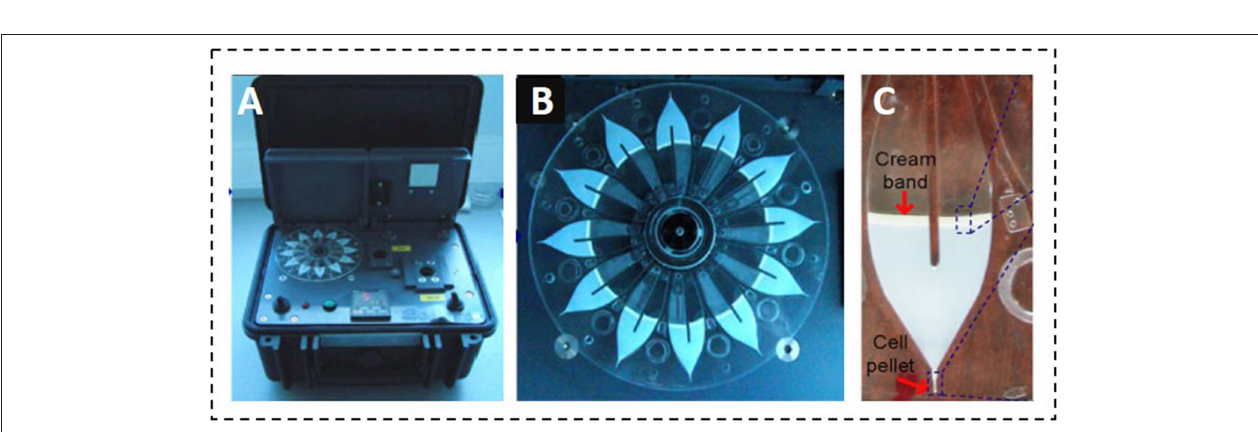
FIGURE 3 | Portable microfluidic sedimentation cytometer proposed by Garcia-Cordero et al. (A) Portable reader to spin the disc; (B) Microfluidic CD cartridge showing the capacity for 12 milk samples; (C) Photographic capture of a centrifuged chamber showing the pellet and the cream band. Adapted with permission from Garcia-Cordero et al. (2010). Copyright 2010 Springer Switzerland AG.